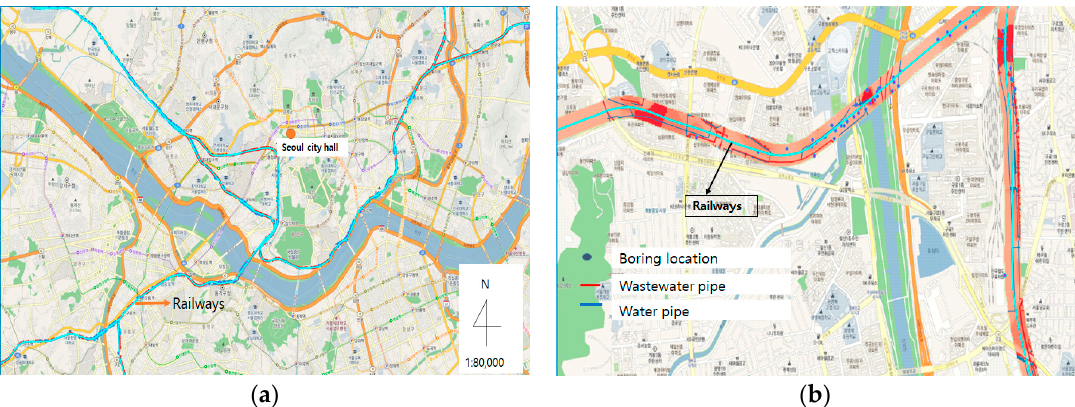
Figure 6. ( a ) Railways of Seoul in mapping system and ( b ) a close-up example of tested locations showing different risk levels.